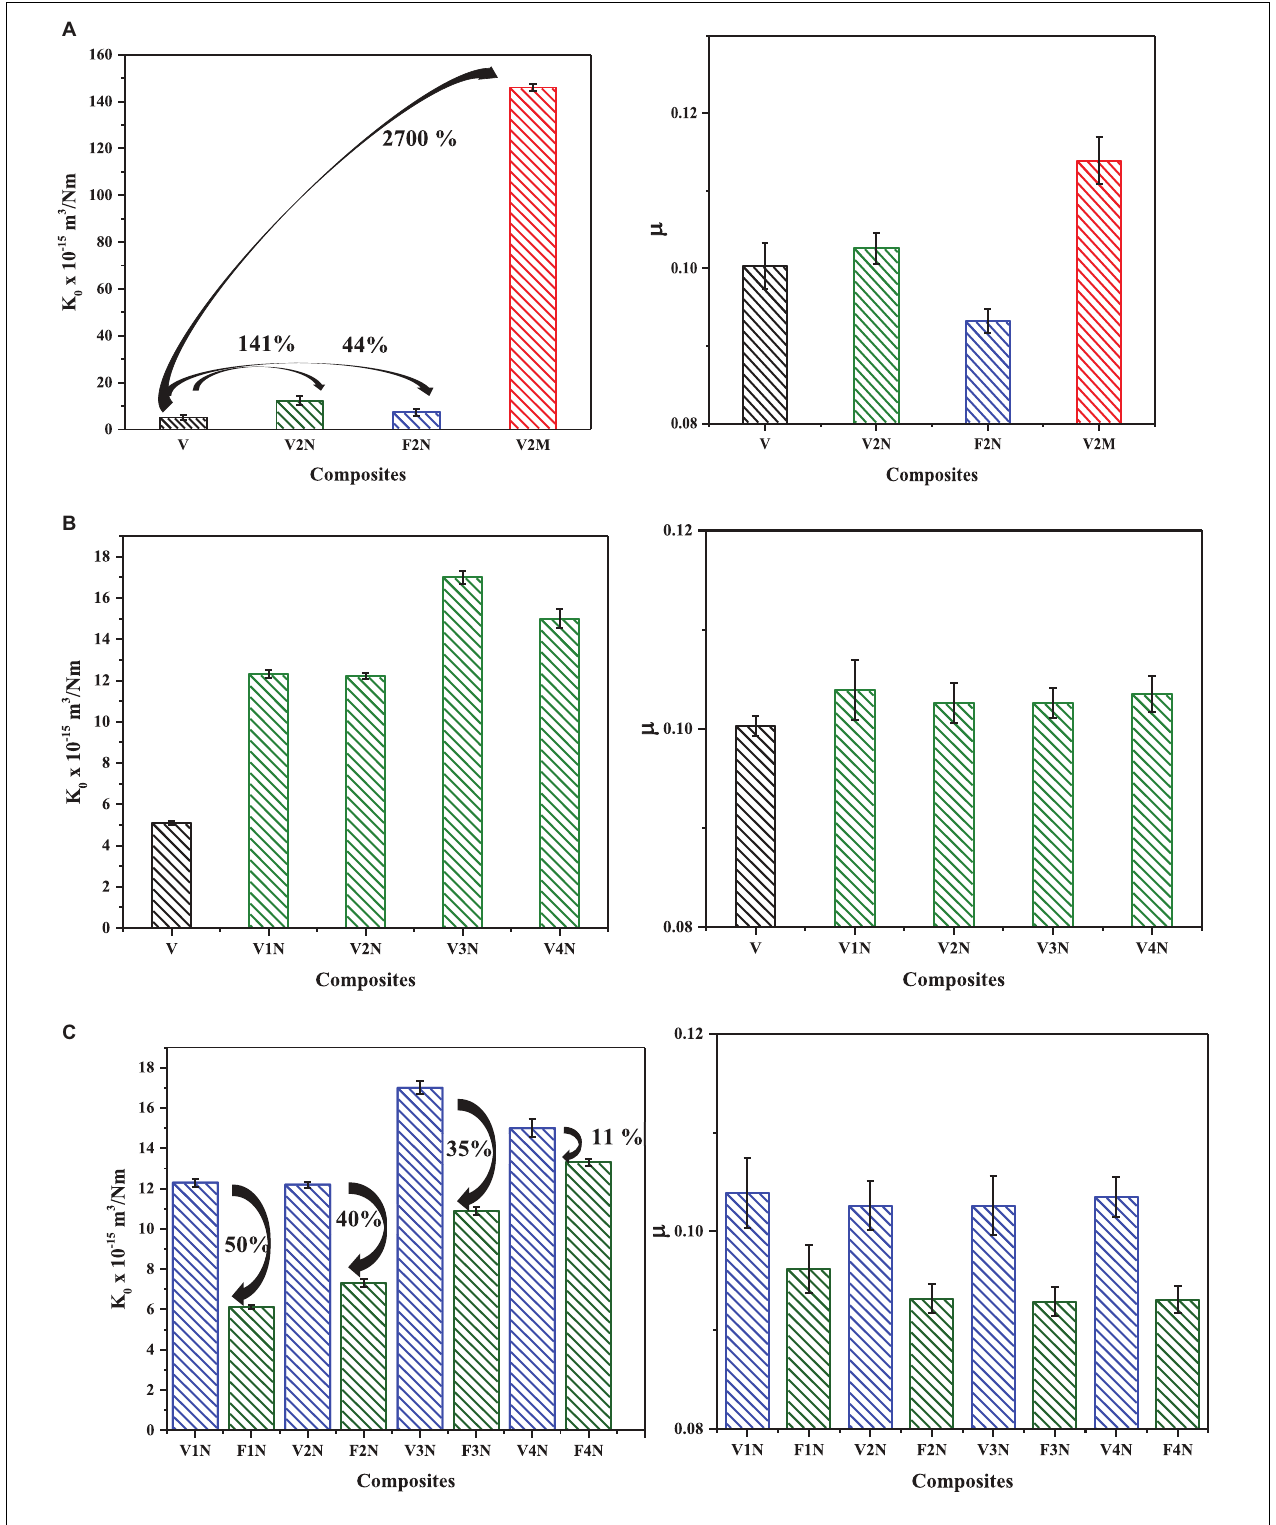
FIGURE 5 | Specific wear rate (K 0 ) (a 1 ,b 1 ,c 1 ) and µ (a 2 ,b 2 ,c 2 ) of composite disks against a ball (P – 73 MPa, speed – 0.014 m/s, sliding duration – 4 h). (A) Comparison of MC, NC, and F-NC (all with 2% particles) with UHMWPE; (B) Influence of increasing amount of NPs, and (C) benefits of functionalization of NPs.